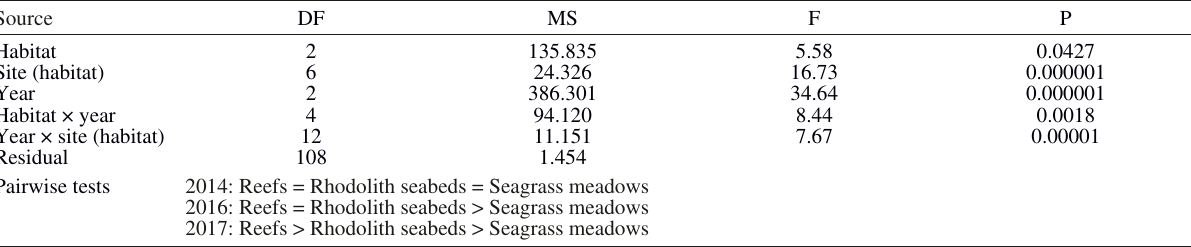
Table 2. – Results of three-way ANOVA testing the effects of habitat (a fixed factor), year (a fixed factor) and site (a random factor nested within habitat) on the abundance of colonies of M. philippina at Gran Canaria Island. Pairwise tests for the significant habitat × year interaction are